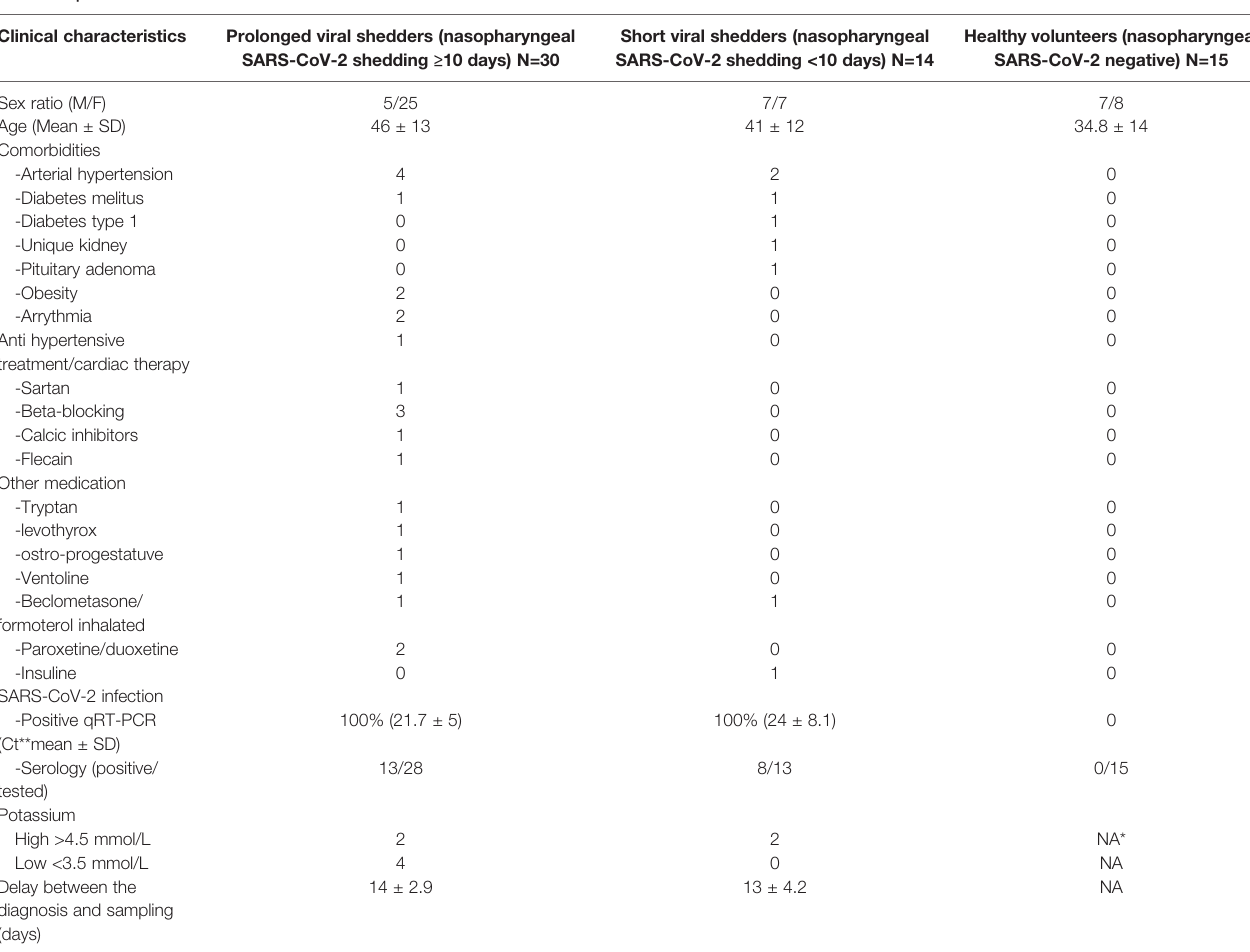
TABLE 1 | Patients/clinical